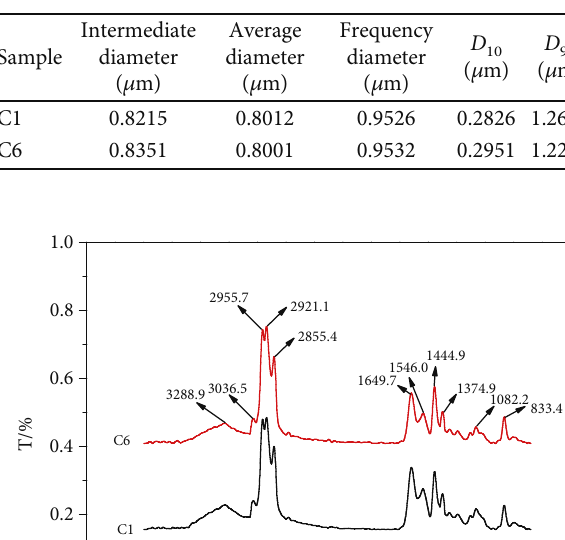
of CNRL raw rubber g